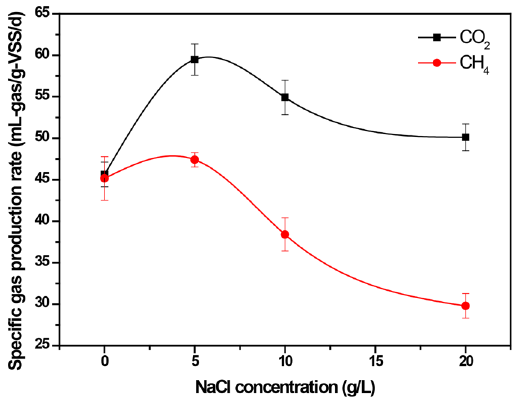
Figure 6. Comparison of specific CH 4 and CO 2 generation rates in different NaCl